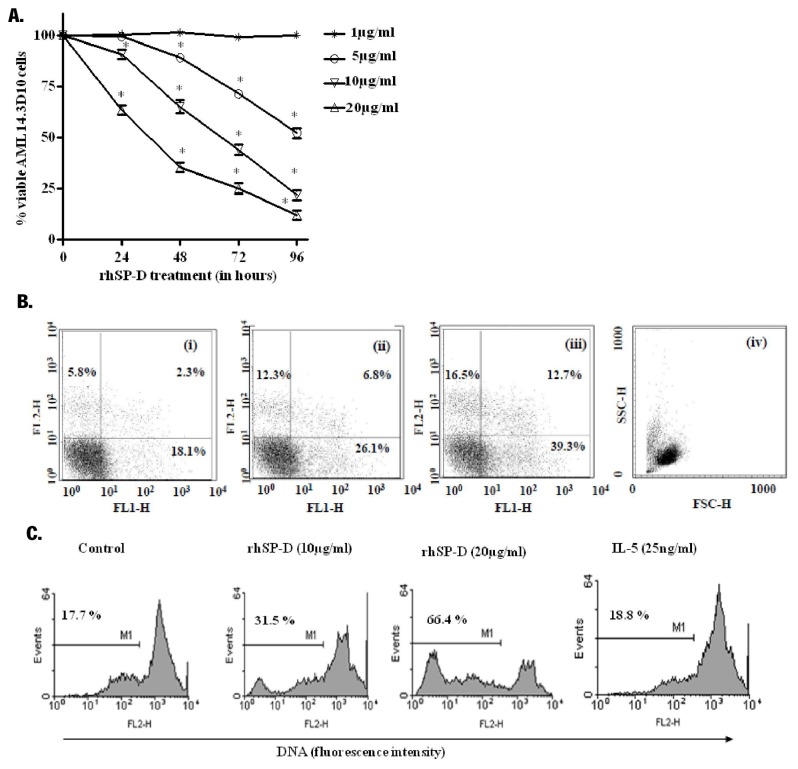
rhSP-D decreases viability of AML14.3D10 cells in a dose and time dependent manner.
A. AML14.3D10 cells were incubated with varying concentrations of rhSP-D (1, 5, 10 or 20µg/ml) for the indicated time intervals. The viability of AML14.3D10 cells was assessed using a modified MTT assay. Results expressed as % viability ± SEM of cells, from 5 independent experiments, with 3 parallel samples in each experiment, in comparison to that of control (taken as 100%) at that time interval and compared by one-way ANOVA and Tukey’s test, * p<0.05 versus control. B. The cells were treated with rhSP-D (10 or 20µg/ml) for 48h and the apoptotic cells were detected by annexin-V-FITC/PI staining (i) Untreated, (ii) rhSP-D (10µg/ml), (iii) rhSP-D (20µg/ml), (iv) FSC and SSC. The increase in PI positive cells in rhSP-D treated cells represents late apoptotic cells. The figure shows representative scatter plots from one of the three independent experiments. C. Representative histograms for rhSP-D induced DNA fragmentation in AML14.3D10 cells studied by hypotonic propidium iodide staining. AML14.3D10 cells were incubated with rhSP-D (10 and 20µg/ml) for 72h at 37°C. IL-5 (25ng/ml) incubated cells with intact DNA were used to define marker (M1). The marker (M1) represents percentage apoptotic cells indicating the sub-diploid DNA. The figure shows representative histograms from one of the three independent experiments.